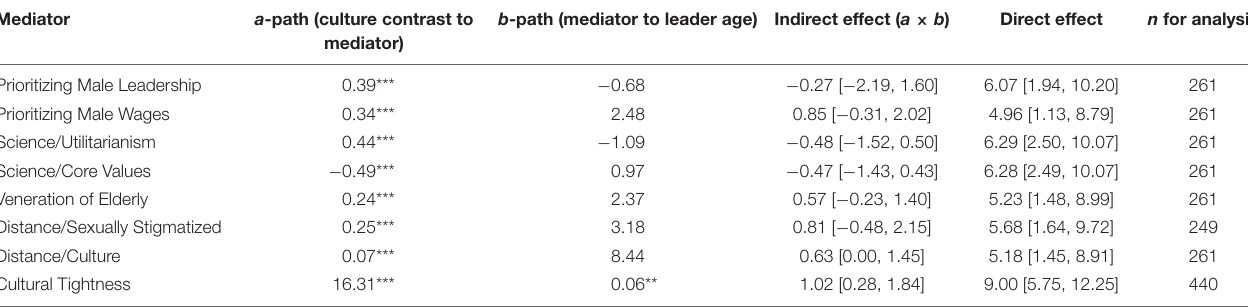
TABLE 2 | Indirect effects from culture contrast to political leader age (Study